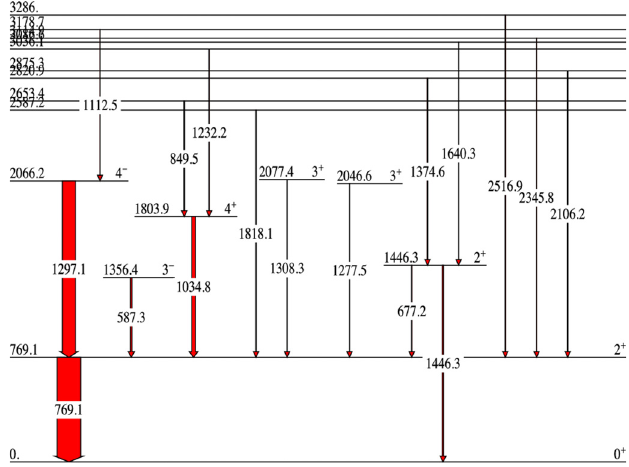
Fig. 6. Low energy part of the level scheme and gamma-cascade of 92 Kr calculated with FIFRELIN (RIPL3-2009). The intensities of 1034 and 1297 keV transitions are reversed.